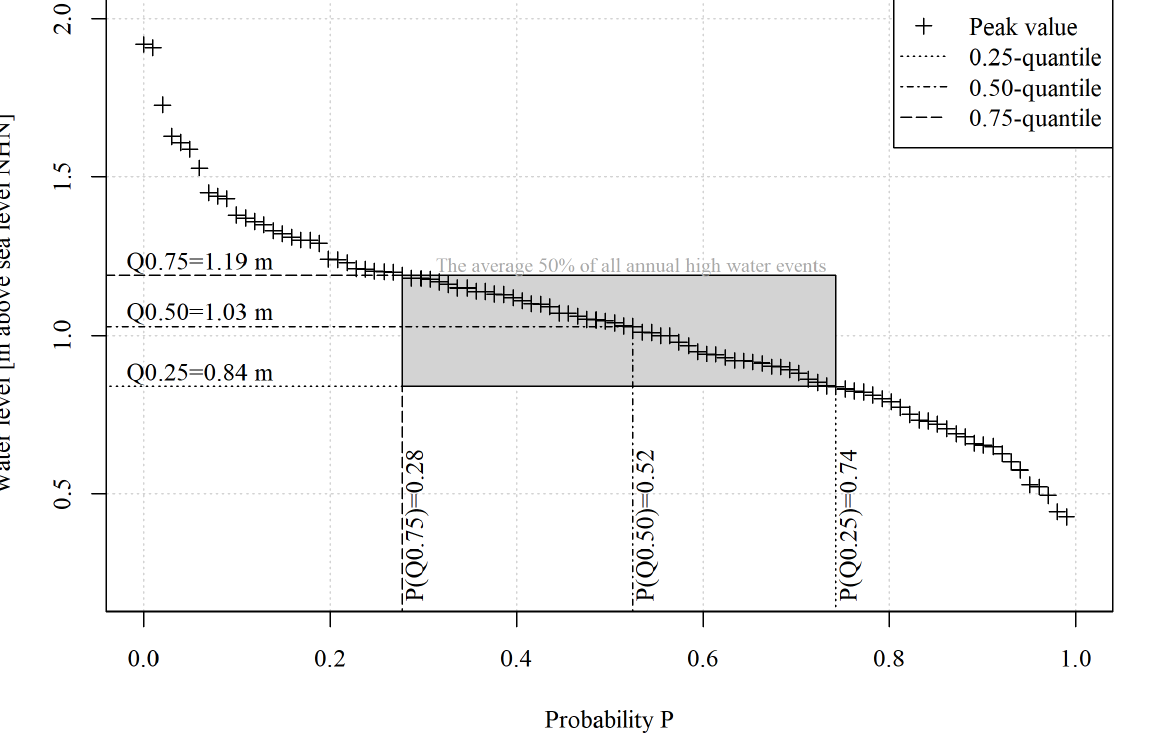
Figure 6. Empirical distribution of the annual maximum water levels, level gauge Rostock-Warnemünde [35].